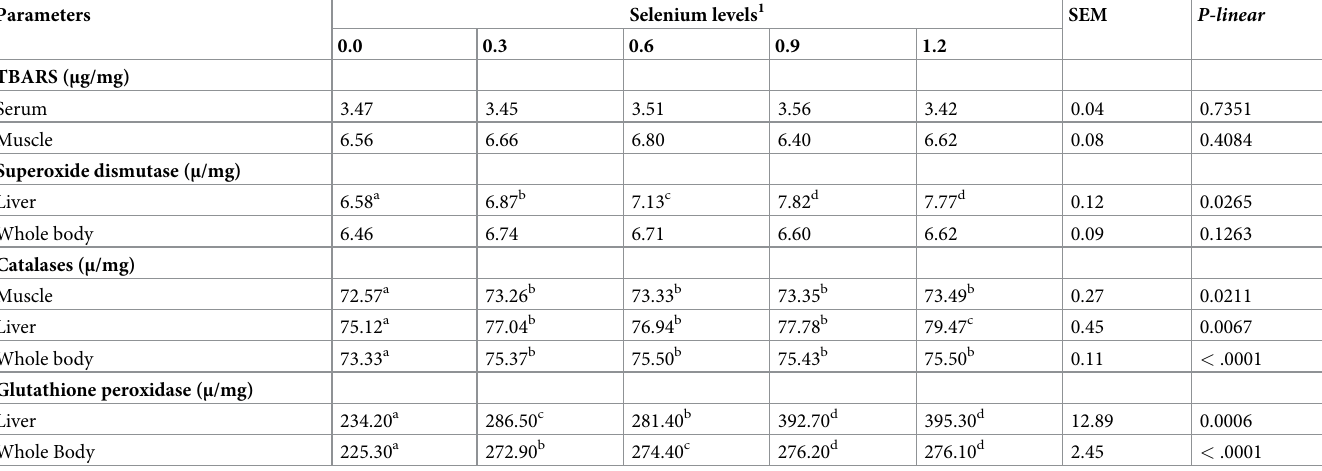
Table 7. TBARS and antioxidant status of juvenile silver carp fed different levels of selenium methionine.